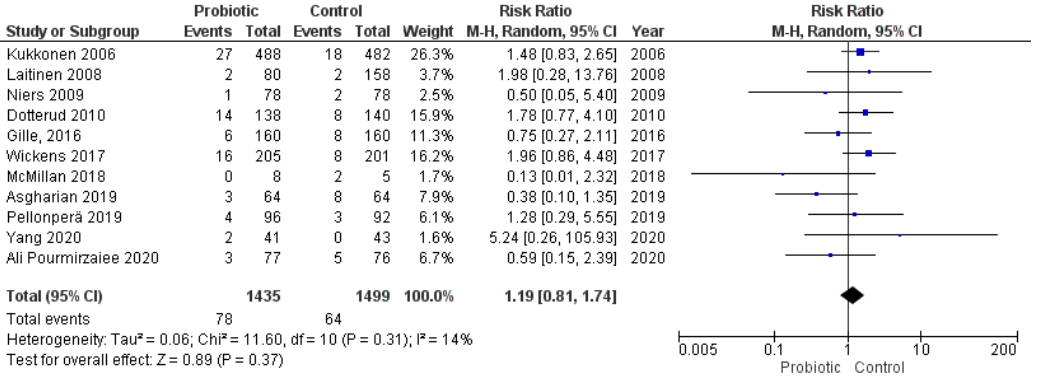
Figure 2. Meta-analysis of studies evaluating the administration of probiotic and preterm birth.